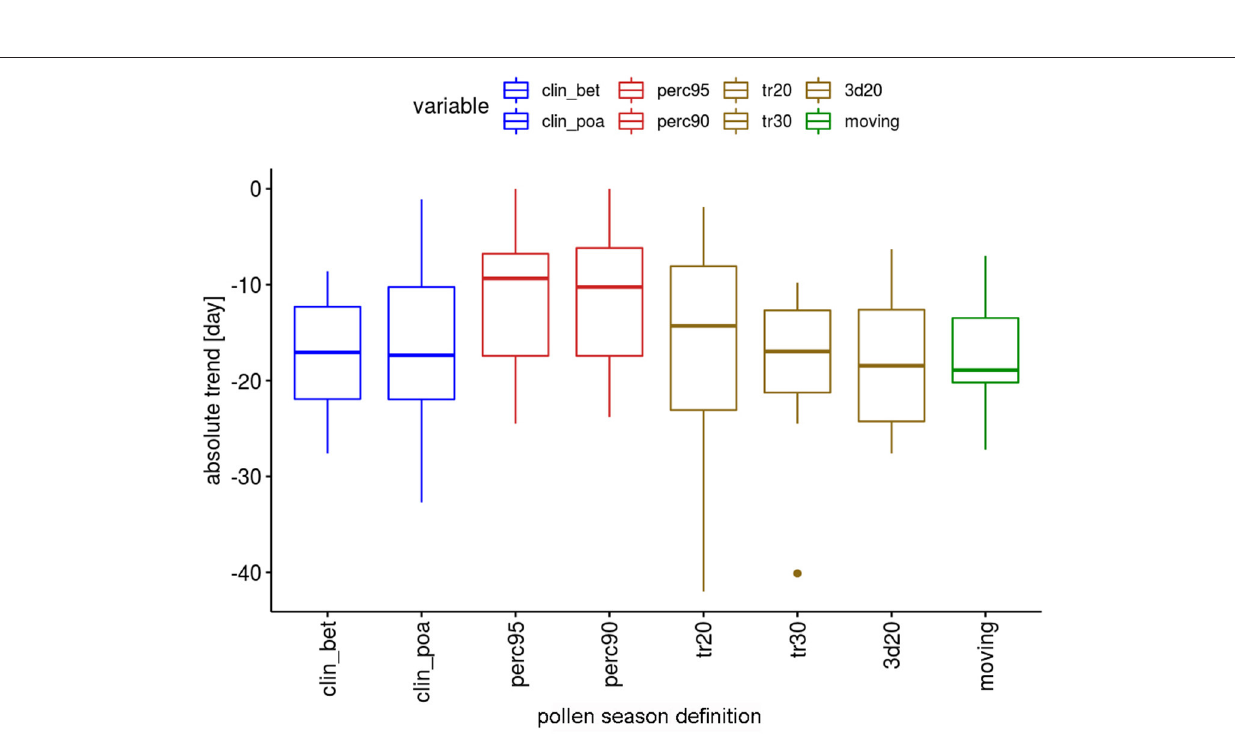
Frontiers in Allergy |